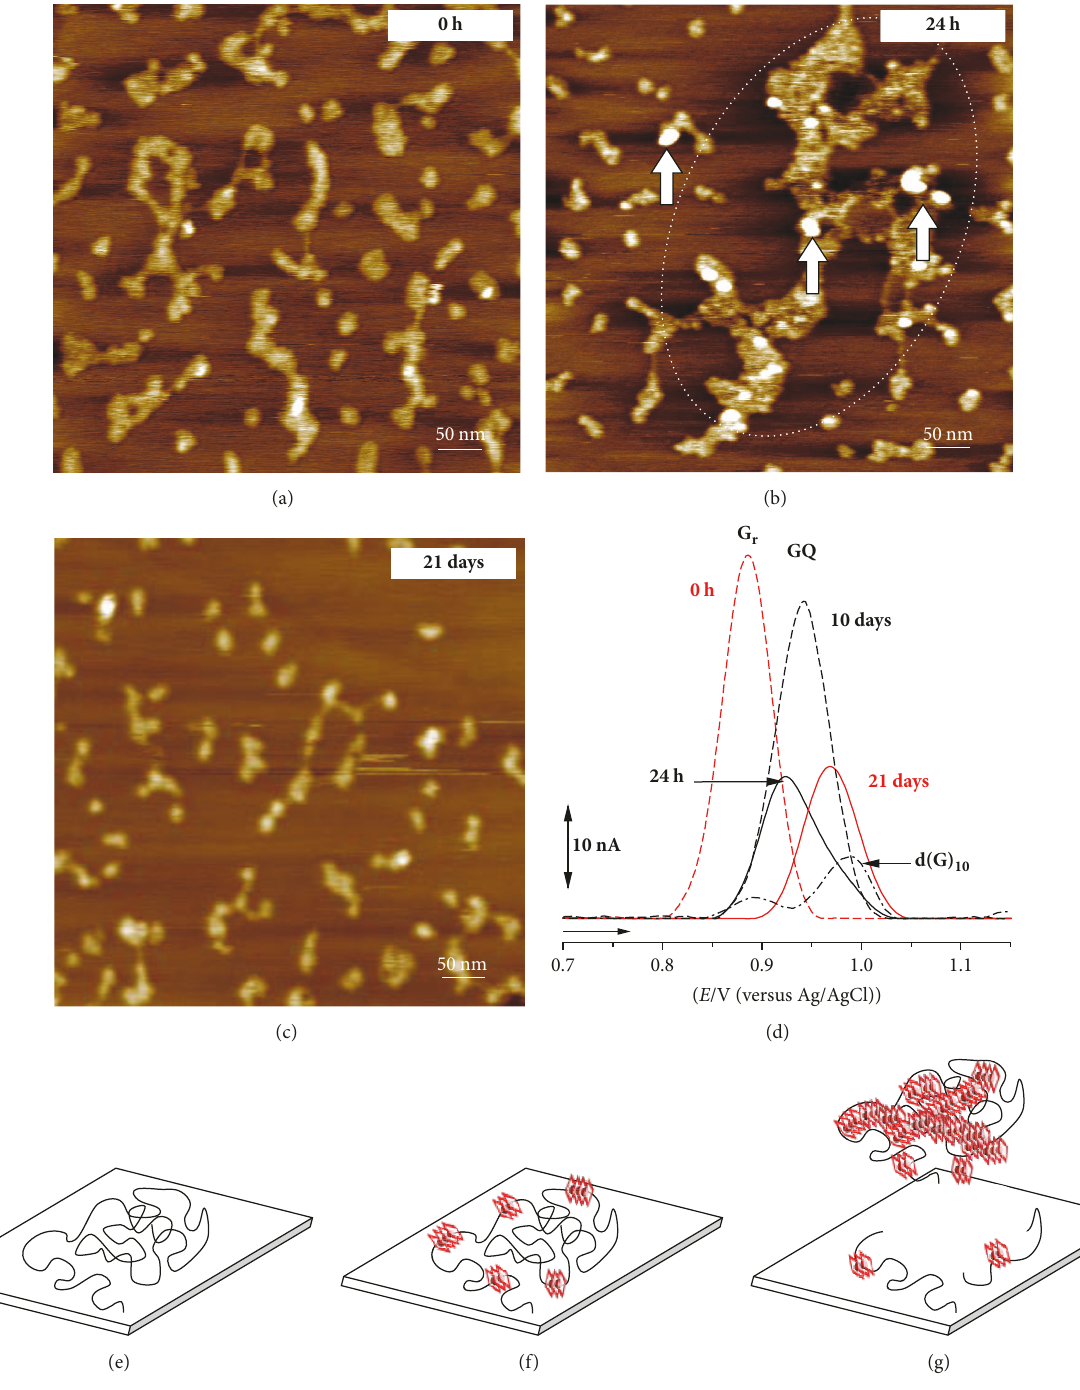
Figure 4: (a–c) AFM images of 5 𝜇 g mL −1 poly(G) in pH 7.0, in the presence of K + ions, at (a) 0h, (b) 24 h, and (c) 21 days’ incubation; (d) DP voltammograms baseline corrected in 100 𝜇 gmL −1 poly(G) in pH 7.0, in the presence of K + ions, at (red dashed line) 0h, (black solid line) 24h, (black dashed line) 10 days, and (red solid line) 21 days’ incubation and control (black dashed-dotted line) 3 𝜇 M d(G) 10 at 24 h incubation; (e–g) representation of poly(G) adsorption process: (e) poly(G) single-strand, (f) poly(G) single-strand with short GQ regions, and (g) poly(G) single-strand with larger GQ regions. [Reproduced from [52] with